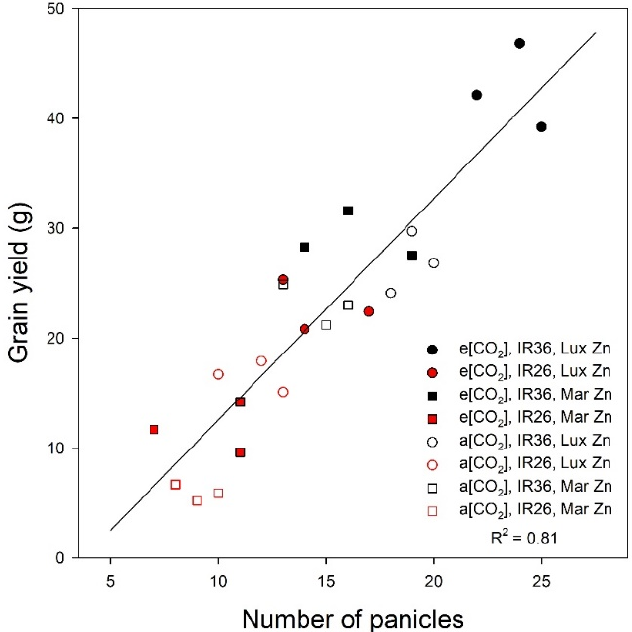
Figure 4. Relation between grain yield and panicle number at maturity. Data are for individual replicates ( n = 3) of each of the eight (var × Zn × CO 2 ) treatment combinations.